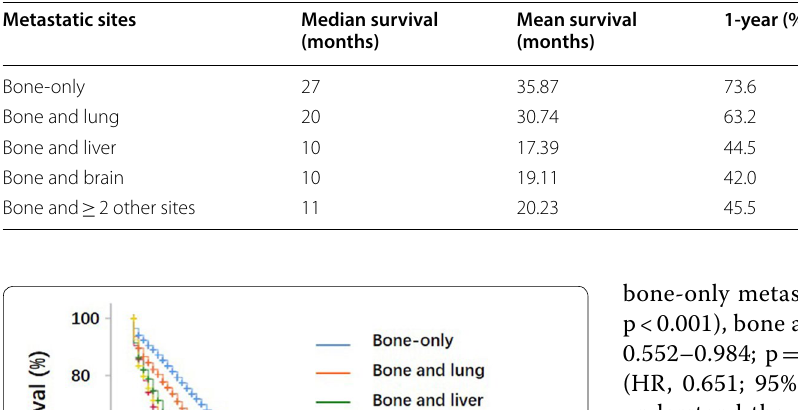
Table 2 Accumulated overall survival (OS) rates (median, mean, 1-, 2-, and 5-year) of de novo prostate cancer patients with bone metastases